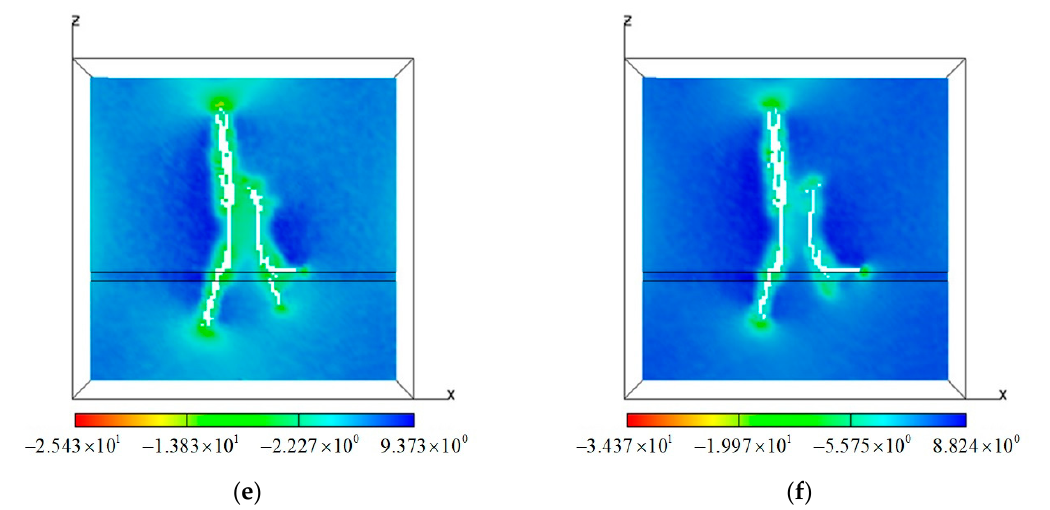
Figure 6. The minimum compressive principal effective stress (MPa) of models with different interlayer Young’s modulus and strength at t = 2000 s: ( a ) Multi-E1, E 1 / E 0 = 0.3; ( b ) Multi-E2, E 2 / E 0 = 0.6; ( c ) Multi-00, E 0 / E 0 = 1.0; ( d ) Multi-E3, E 3 / E 0 = 1.4; ( e ) Multi-E4, E 4 / E 0 = 1.7; ( f ) Multi-E5, E 5 / E 0 =